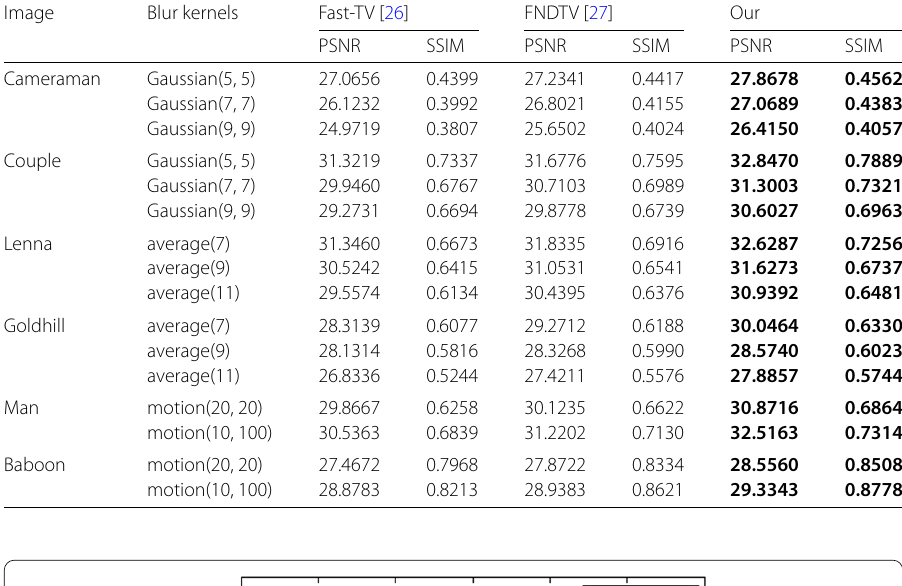
Table 1 Experimental results for different images and different blur kernels, BSNR = 35 Image Blur kernels Fast-TV [26] FNDTV [27] Our